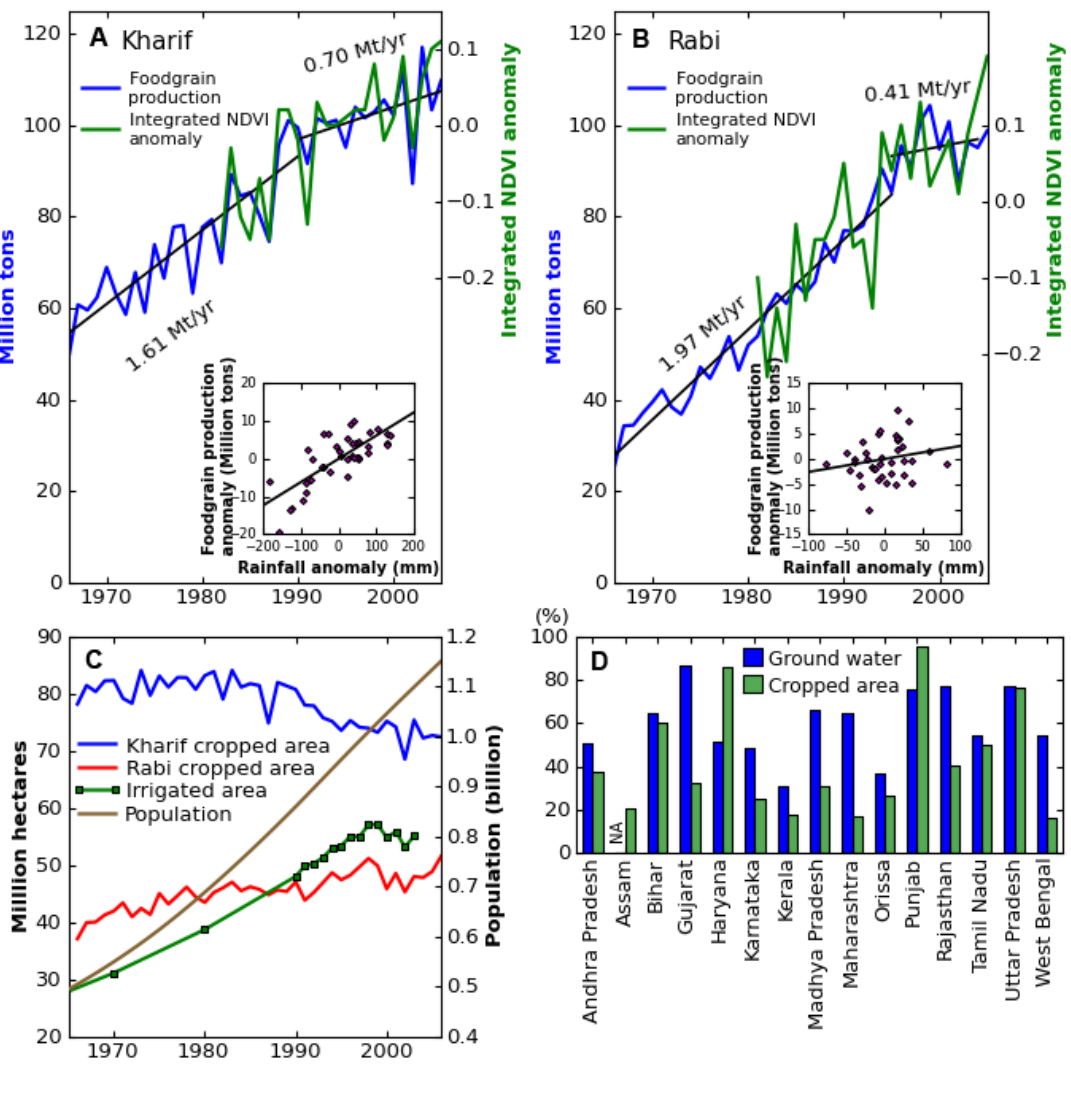
Figure 5. Total food grain production (rice, wheat, coarse cereals, and pulses) during the (A) kharif (summer, rainy) and (B) rabi (winter, dry) seasons in India over the past four decades. Food grain production (Million tons/yr; blue, left axis) and corresponding growth rates are displayed for the period 1966/67 to 2005/06. Also shown are anomalies of seasonally integrated satellite vegetation greenness (iNDVI) over the croplands of India for the kharif and rabi cropping seasons from 1981/82 to 2005/06 (green, right axis). The insets of A and B show the correlation between food grain production anomalies and rainfall anomalies (during kharif r = 0.76, rabi r = 0.11). (C) Annual cropped area under food grains during kharif (blue) and rabi (red) seasons, annual net irrigated area (green squares), and population (brown). (D) % of cropland irrigated across the main agricultural states of India and % of irrigated cropland area relying on groundwater